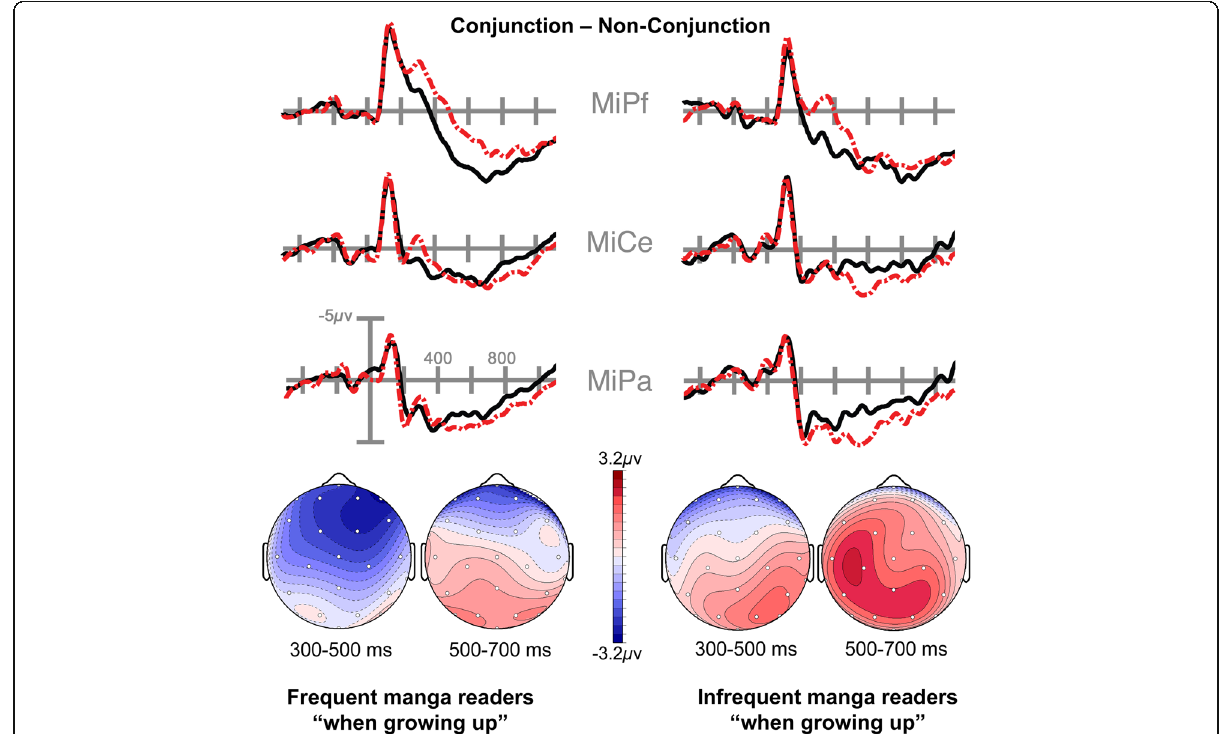
Fig. 6 Midline electrode sites and topographic voltage maps representing distribution across the scalp for the difference between Non-Conjunction and Conjunction sequences for frequent and infrequent readers of Japanese manga “ while growing up. ” Pa parietal, Pf prefrontal, Mi Midline, Ce